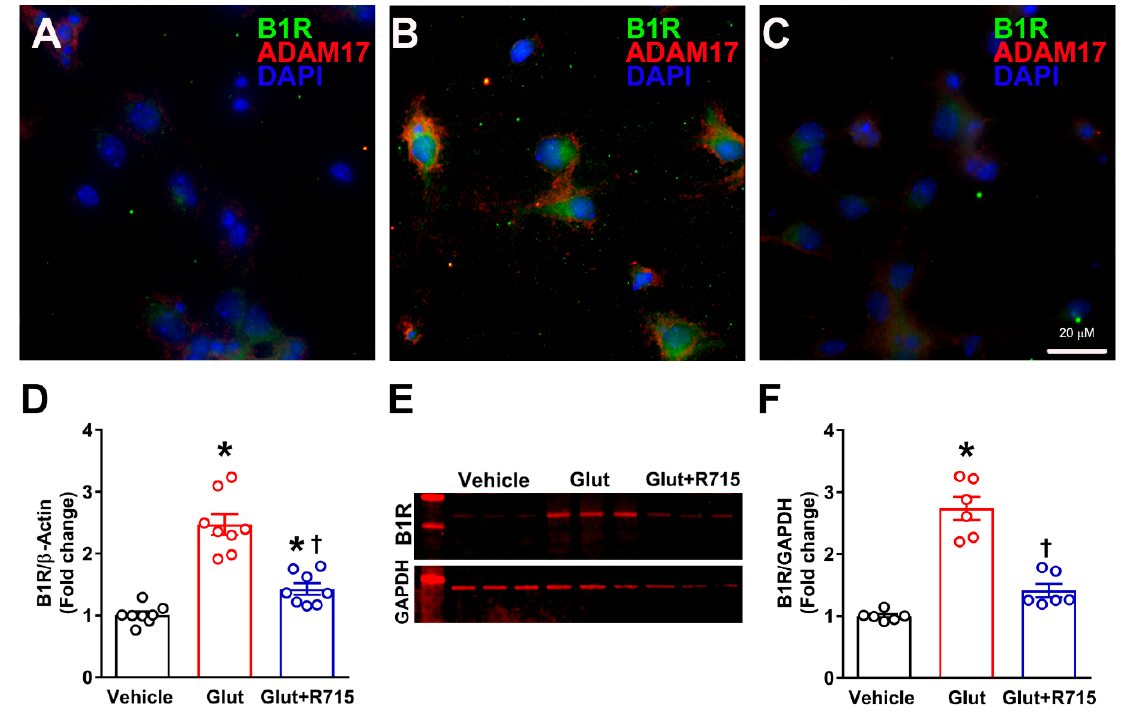
Figure 4. Effect of glutamate on B1R activation in primary hypothalamic neurons. Representative triple immunostaining revealed that compared to vehicle ( A ) treatment, stimulation with glutamate (100 μ M) ( B ) for 18 h induced the expression of kinin B1R and ADAM17 protein in primary hypothalamic neurons. This glutamate-induced increase in B1R and ADAM17 protein expression was prevented by pre-treatment with R715 ( C ). Treatment with glutamate (100 μ M) for 4 h induced an increase in B1R mRNA in cultured neurons, measured by real time PCR. This increase in B1R mRNA was prevented by pre-treatment with R715 ( D ). Representative image of Western blot ( E ) and quantitative analysis ( F ) showing glutamate stimulation induced B1R protein expression which was prevented by pre-treatment with R715 in neurons ( n = 4–6 independent cultures/group). Statistical significance: one-way ANOVA followed by Tukey’s multiple comparisons test. * p < 0.05 compared vehicle, † p < 0.05 compared to